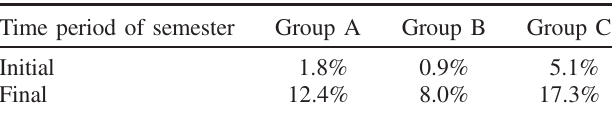
TABLE I. Intergroup interactions at the beginning and at end of the semester. Numbers are percent of total time spent talking to other groups in the second experiment of the semester (Initial) and penultimate lab of the semester